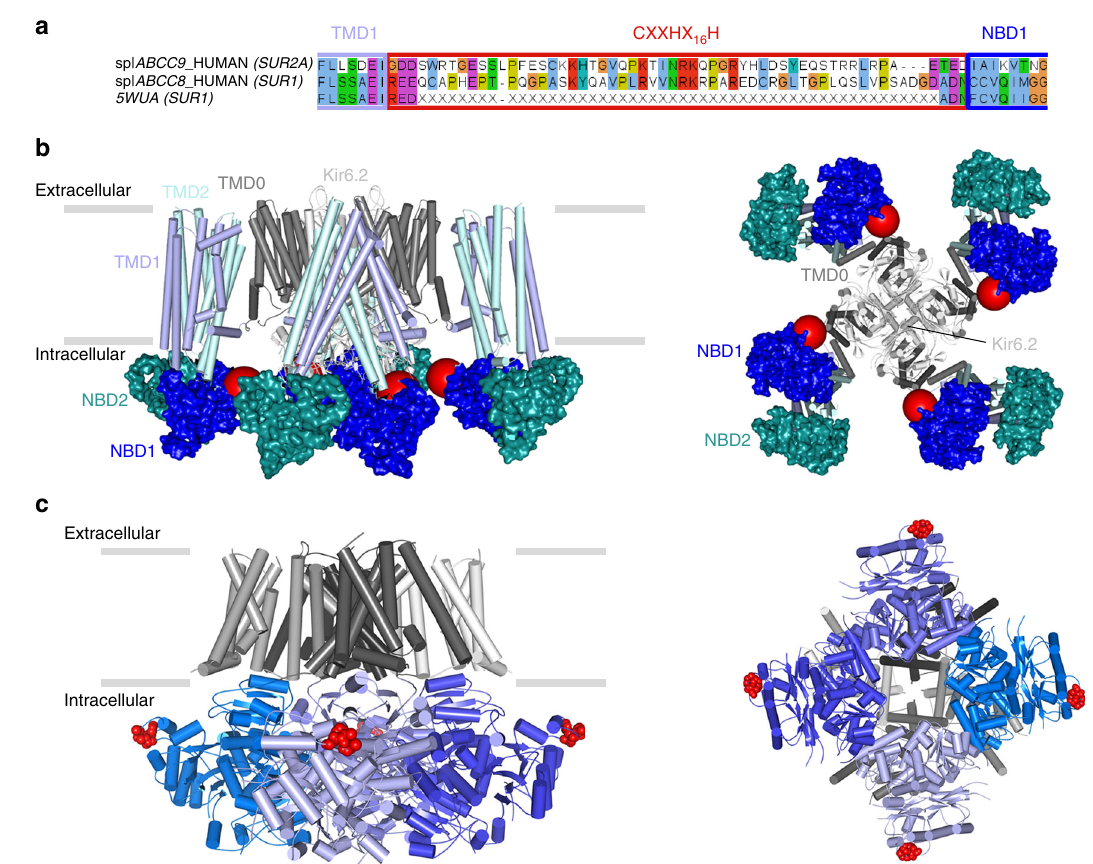
Fig. 5 A structural basis for heme binding. a Sequence alignment between two isoforms of the SUR subunit — SUR2A (ABCC9_HUMAN) and SUR1 (ABCC8_HUMAN and 5WUA). Only the heme binding region of SUR2A and the equivalent region of SUR1 (red box) are shown; the adjacent TMD1 and NBD1 domains are indicated by boxes in light and dark blue respectively. Residues not resolved in the sequence of the equivalent region of the 5WUA cryo- EM structure 42 are listed as ‘ X ’ ; the clustal colour scheme indicates biophysical properties of amino acids. b Domain structure of the Kir6.2/SUR2A K ATP channel mapped on the EM structure of the pancreatic ATP-sensitive potassium channel (PDB 5WUA 42 ), viewed along the membrane plane (left) and perpendicular to the membrane from the intracellular space (right). The colour scheme follows that in Fig. 1: Kir6.2 (light grey), TMD0 (dark grey), TMD1 (light blue) and TMD2 (light cyan) domains of SUR2A in cartoon representation; NBD1 (dark blue) and NBD2 (dark cyan) of SUR2A are shown in surface representation. The region corresponding to the heme binding domain in SUR2A is not resolved in the corresponding SUR1 domain of 5WUA, its putative location is indicated by a red sphere. c Domain structure of the Slo1 channel tetramer (PDB 5TJ6 44 ) shown in an equivalent orientation to ( b ) above. Transmembrane domains are in grey, intracellular RCK1/2 domains in blue, and individual monomers are indicated by different shades of grey/blue, respectively. The CXXCH heme binding motif in Slo1 is resolved in the structure (in red). Unlike Kir6.2/SUR2A, where the heme binding region is part of an unstructured region which is not resolved in the structure (red sphere in ( c )), the heme binding motif in Slo1 is resolved (actual residues shown in red) but in close proximity to other unstructured residues/regions which are not visible in the